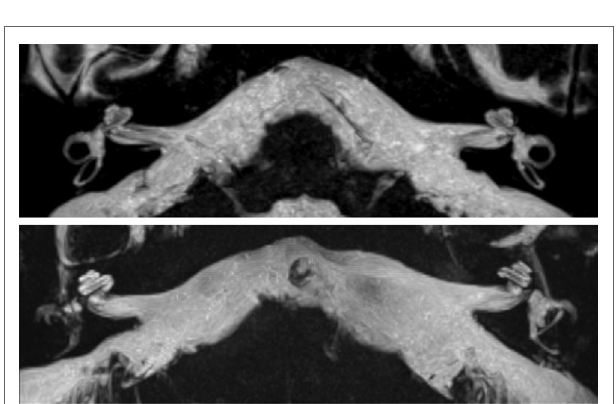
FigUre 2 | axial T2-weighted turbo spin echo Mri of the left labyrinth demonstrating the signal loss in the lateral semicircular canal (arrow) corresponding to the axial cT-slice in Figure 1 .